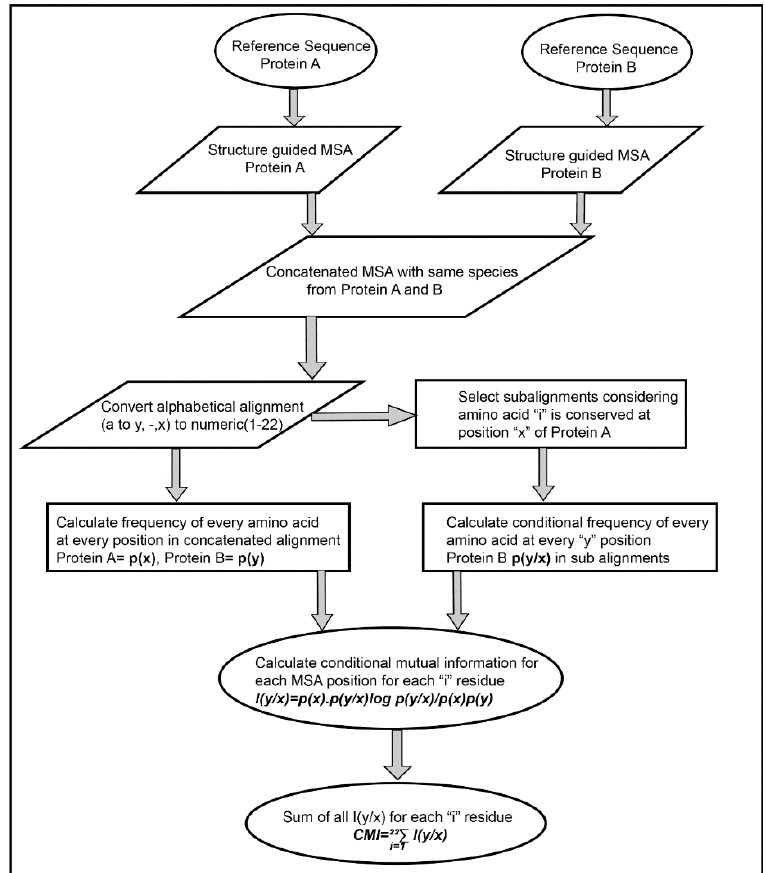
Figure 2. Flow chart representing an algorithm for calculating inter-protein co-evolving positions from multiple sequence alignments.